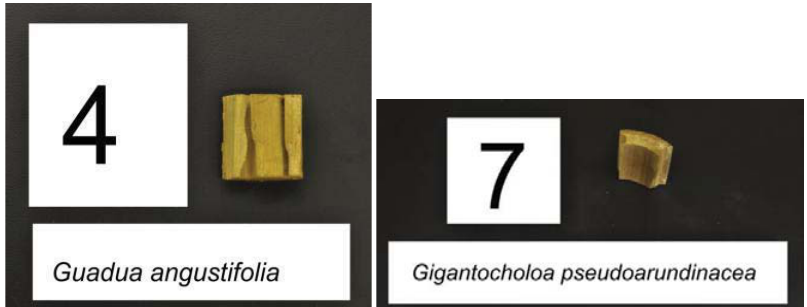
Figure 5. Sample visual ratings for C. formosanus